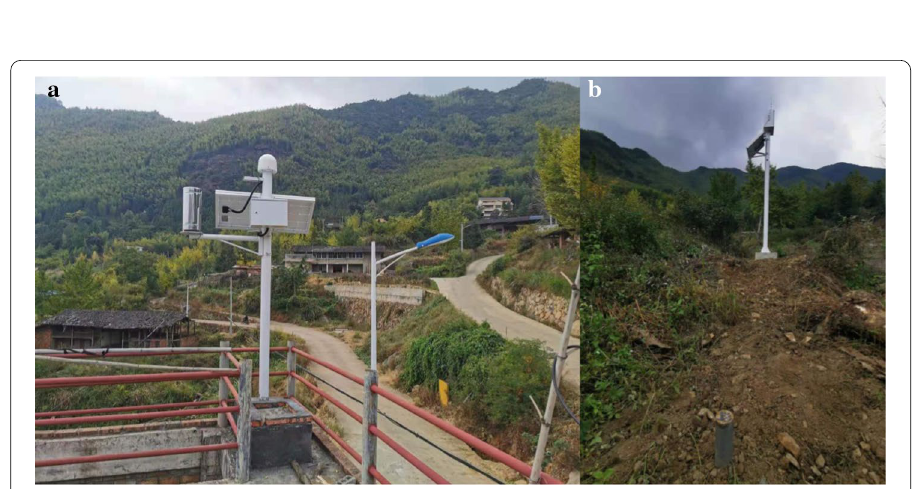
Fig. 9 a GNSS reference station with automatic rainfall monitoring station; b automatic monitoring station for tensioned cracks on the back edge of the